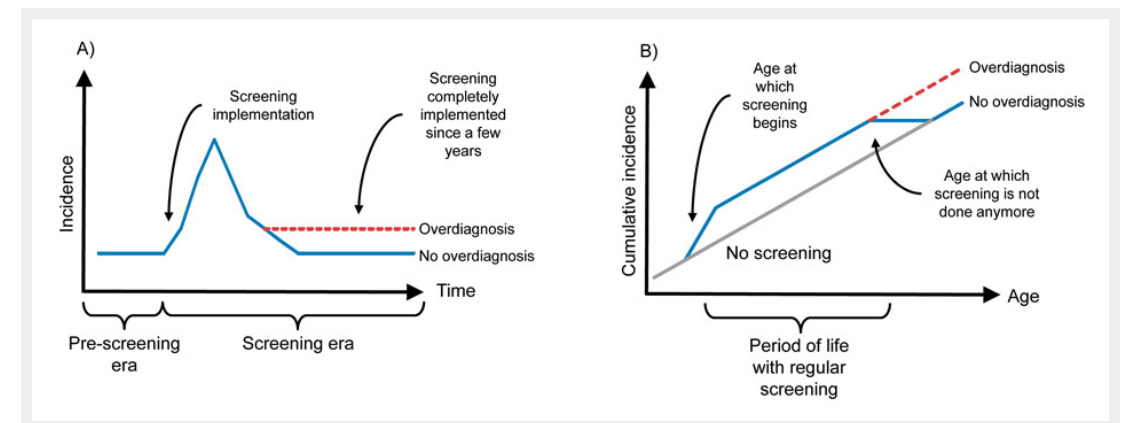
Panel A) Following the implementation of cancer screening, assuming no true change in the frequency of cancer, the observed incidence will initially increase before reaching again, in the long term, the incidence observed in the pre-screening era. In case of over-diagnosis, in the long term, the incidence does not return to pre-screening level due to the excess cases detected [43]; Panel B) Comparing cumulative incidence of screened and unscreened population can demonstrate over-diagnosis due to a screening test done regularly during a given period of life, e.g., mammography for breast cancer. During the period of screening, the cumulative incidence is higher with screening than without screening. Few years after the end of screening period, the cumulative incidence in the screened population reach the cumulative incidence in the unscreened population if there is no over-diagnosis. In case of over-diagnosis, the cumulative incidence remains higher [40, 43,